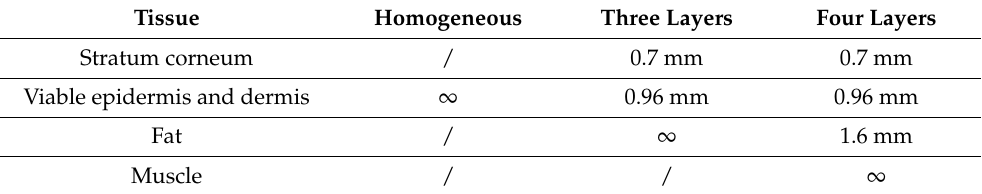
Table 1. Thickness of the layers in the three different skin models.